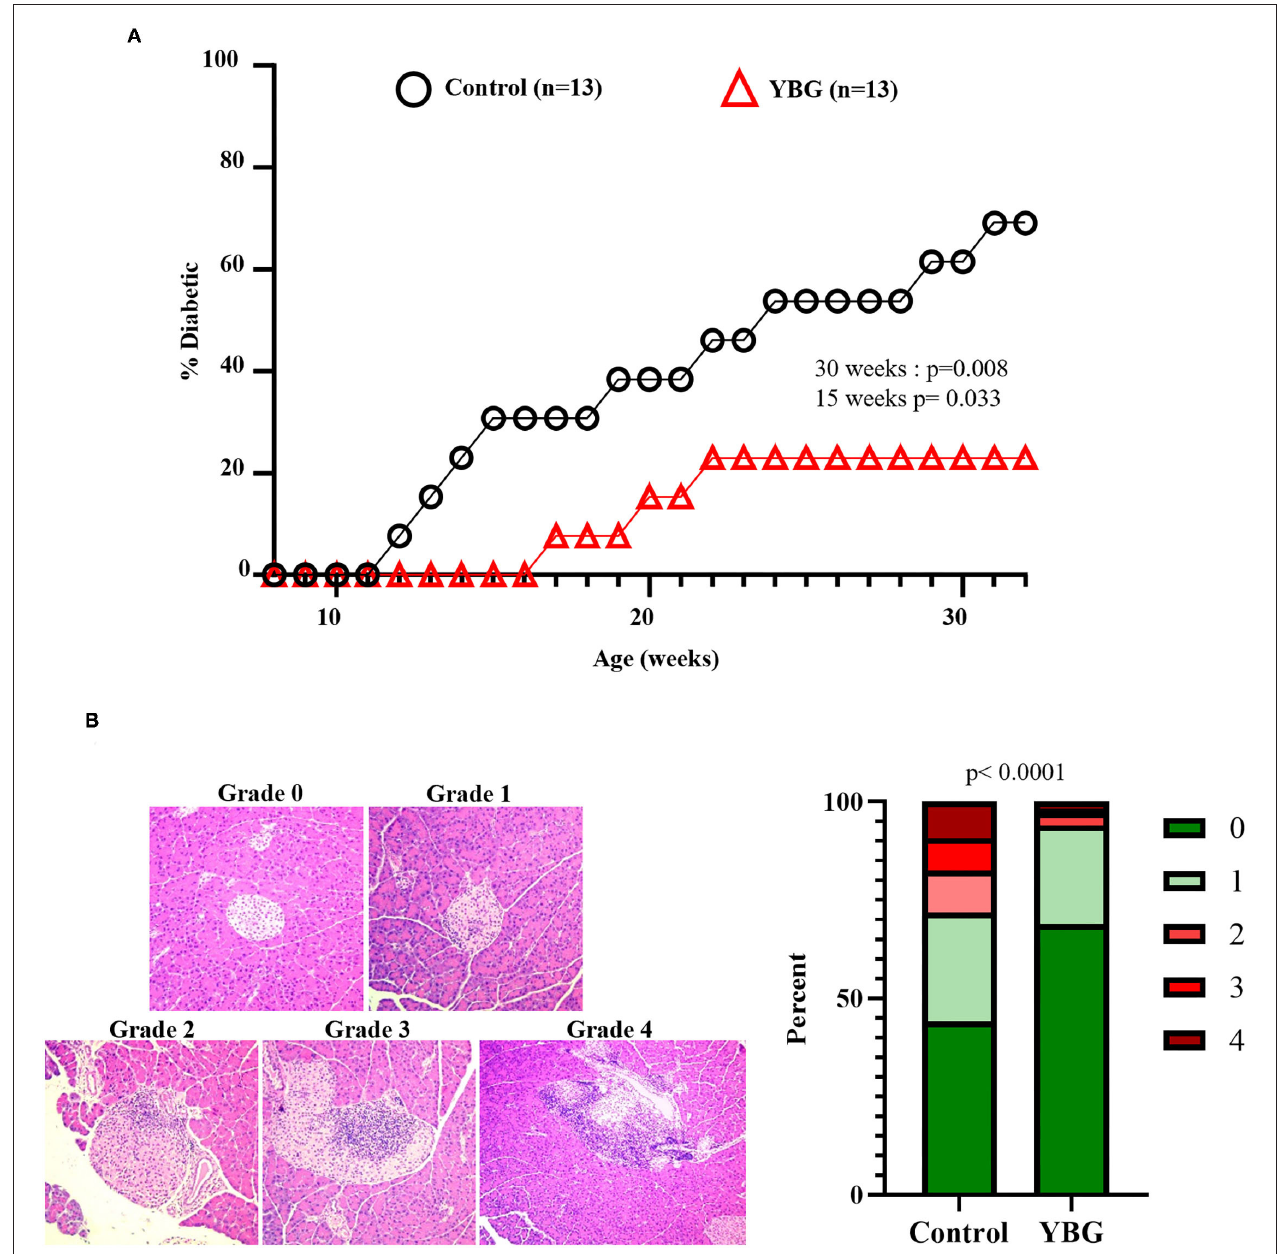
FIGURE 5 | Impact of 30-day YBG treatment starting at juvenile age on eventual T1D disease onset and insulitis in NOD mice. Two-week-old female NOD mice were given saline or 100 µ g YBG suspension for 30 consecutive days as described previously. Starting at 8 weeks of age, blood glucose levels of these treated mice were monitored weekly for up to 30 weeks of age to detect hyperglycemia onset and the overall T1D incidence (A) . Pancreatic tissues were collected from an additional cohort of control and YBG treated mice (4 mice/group) and the sections were subjected to H&E staining to assess the insulitis severity (B) . Representative images showing insulitis severity grades (left panel) and the percentage of islets with different insulitis grades (right panel) are shown. Statistical analysis was performed using a log-rank test (A) and Fisher’s exact test (B) .